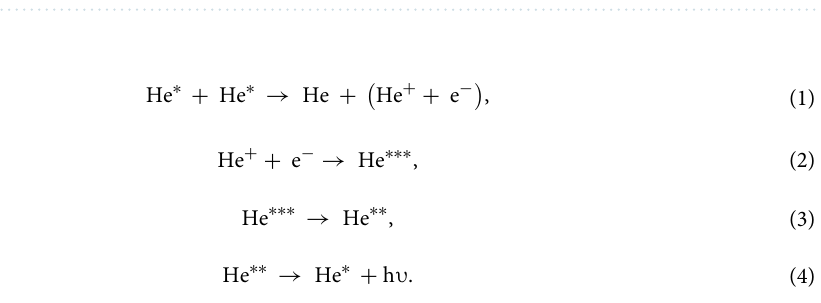
Figure 3. Emission intensity of He I 587.6 nm (triplet) and He I 667.8 nm (singlet) lines when only the first laser with an energy of 82 mJ is focused onto different sub-targets in the surrounding He gas at 3 kPa. The gate delay and gate width of the detection system were set as 200 ns and 50 μs, respectively, after the initiation of the first